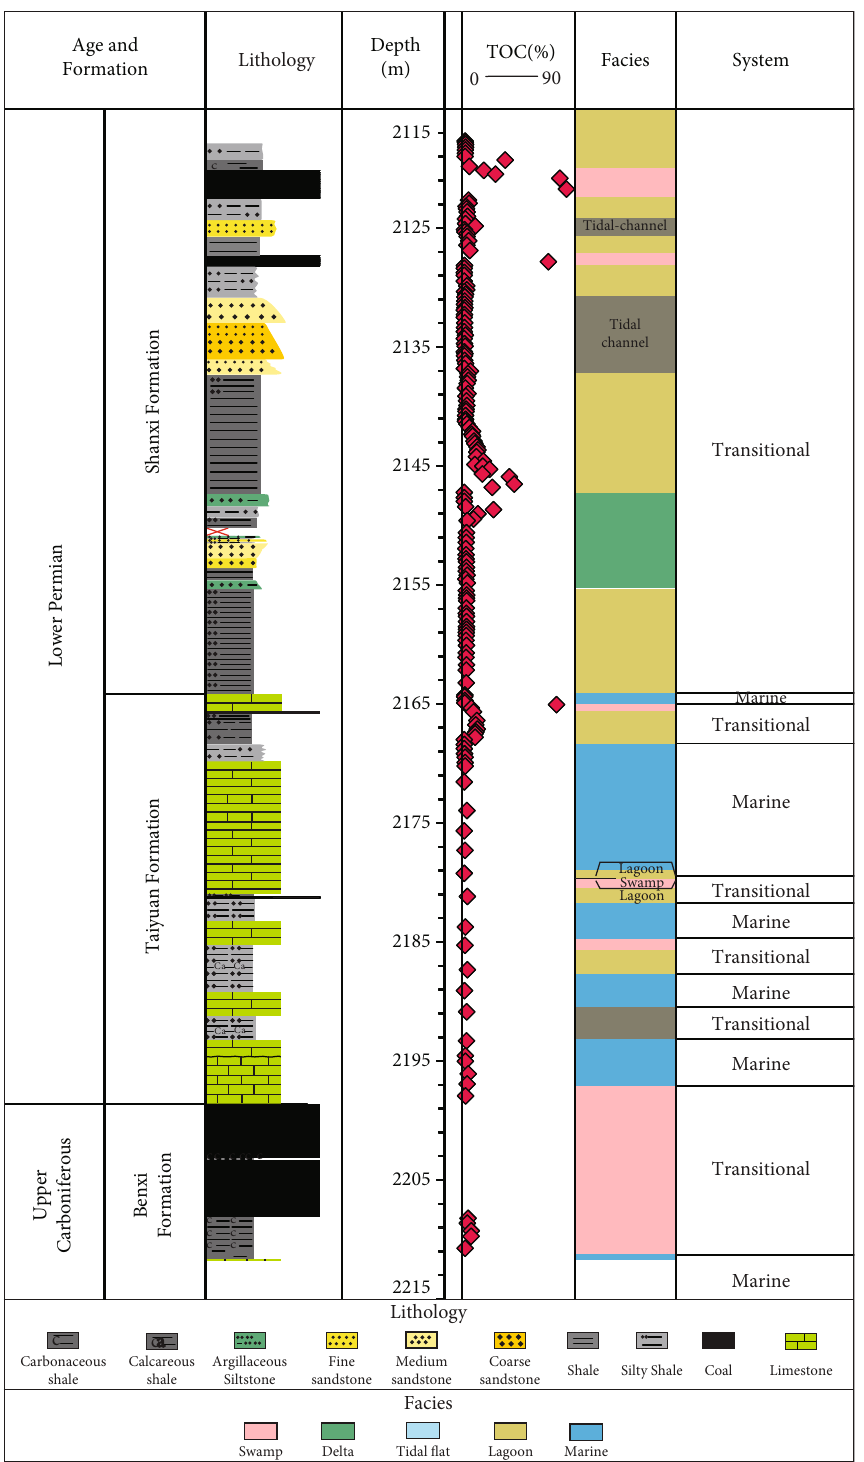
Figure 2: Stratigraphic chart of the study area. The Lower Permian Shanxi and Taiyuan formations are investigated in this study (modi fi ed from